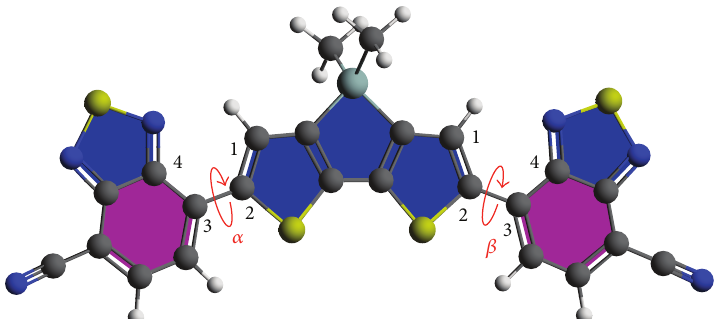
Figure 1: Structure of the BCNDTS molecule. The interring torsional angles, 𝛼 and 𝛽 , are zero when C–C–C–C (numbered by 1, 2, 3, and 4) angles are in cis conformations shown. In the present computations, the methyl group replaces octyl